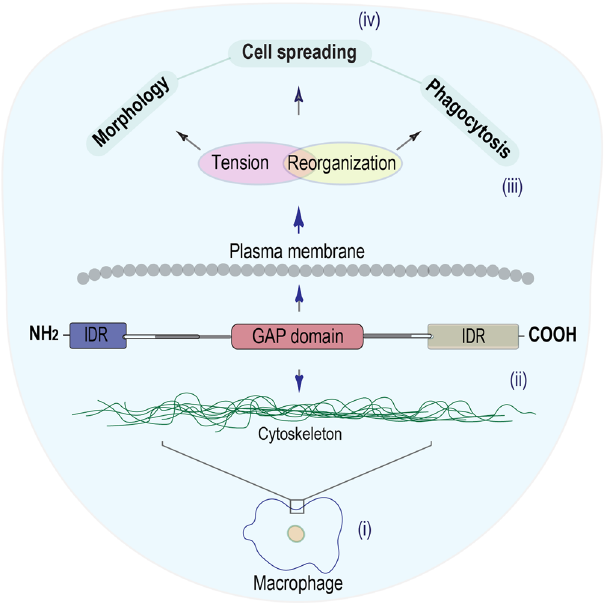
Figure 6. Model of the TBC1D10C’s role in macrophages. We propose, according to our results, that TBC1D10C is a functional linker for the cytoskeleton-plasma membrane (possibly contributing the N-terminal IDR of TBC1D10C), to cytoskeleton-plasma membrane tension and reorganization for cellular processes such as cell spreading, morphology, and